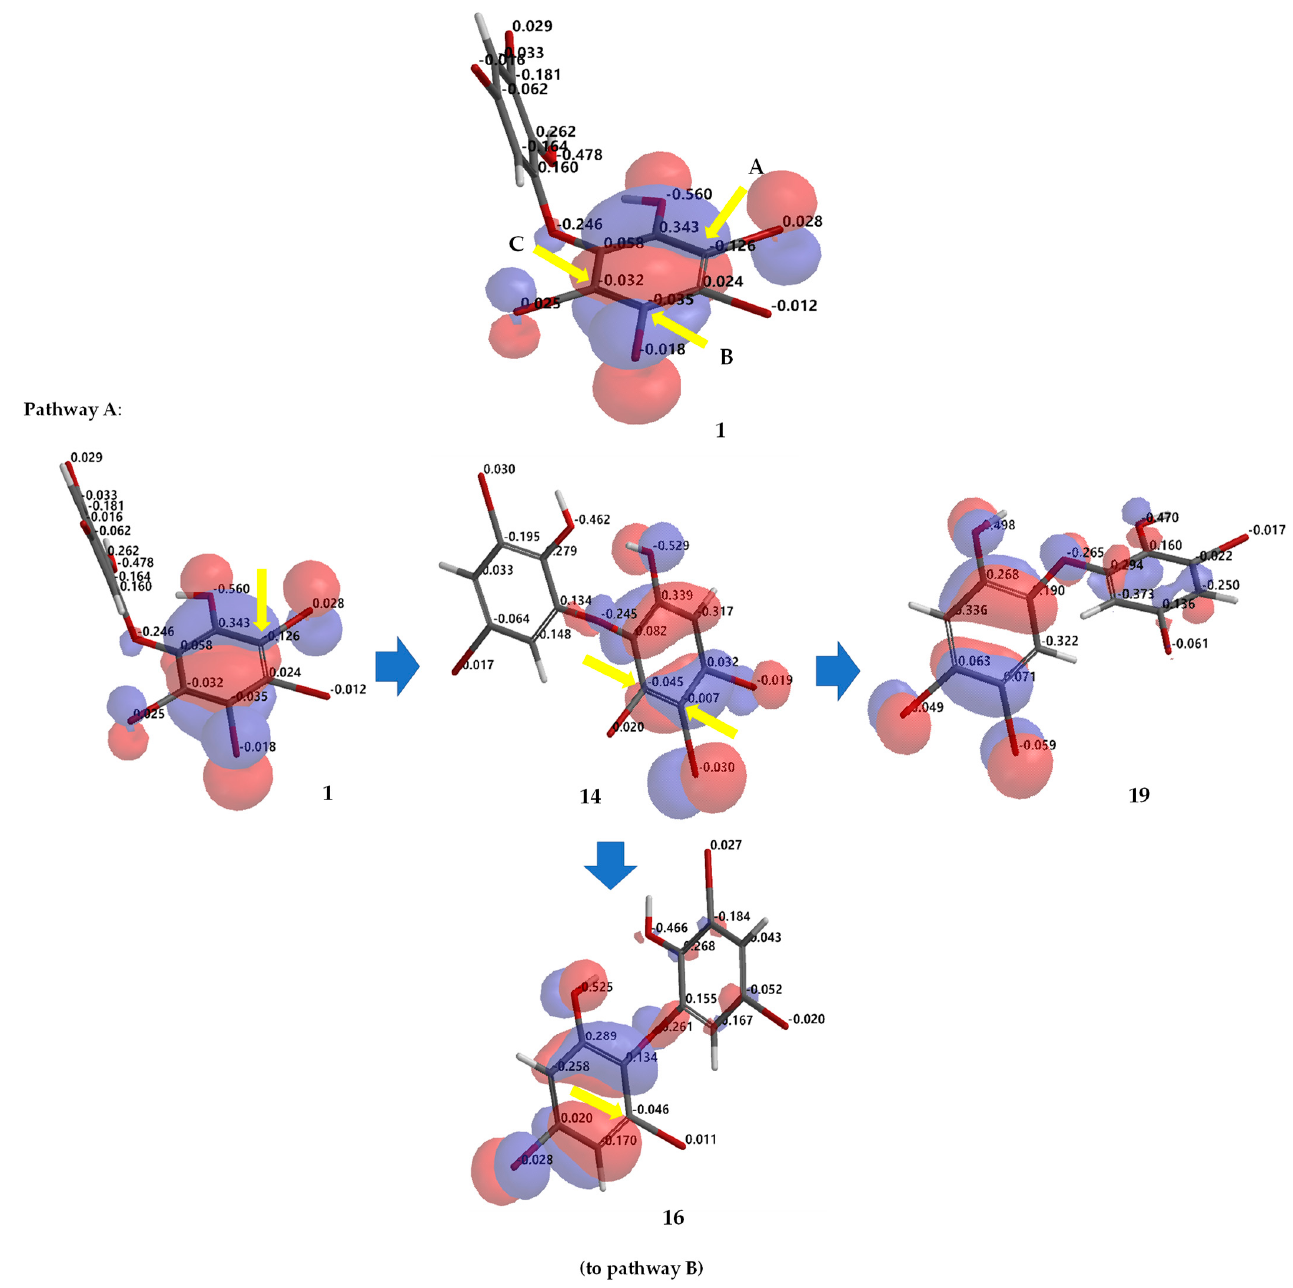
Figure 7. Figure 7. Cont.